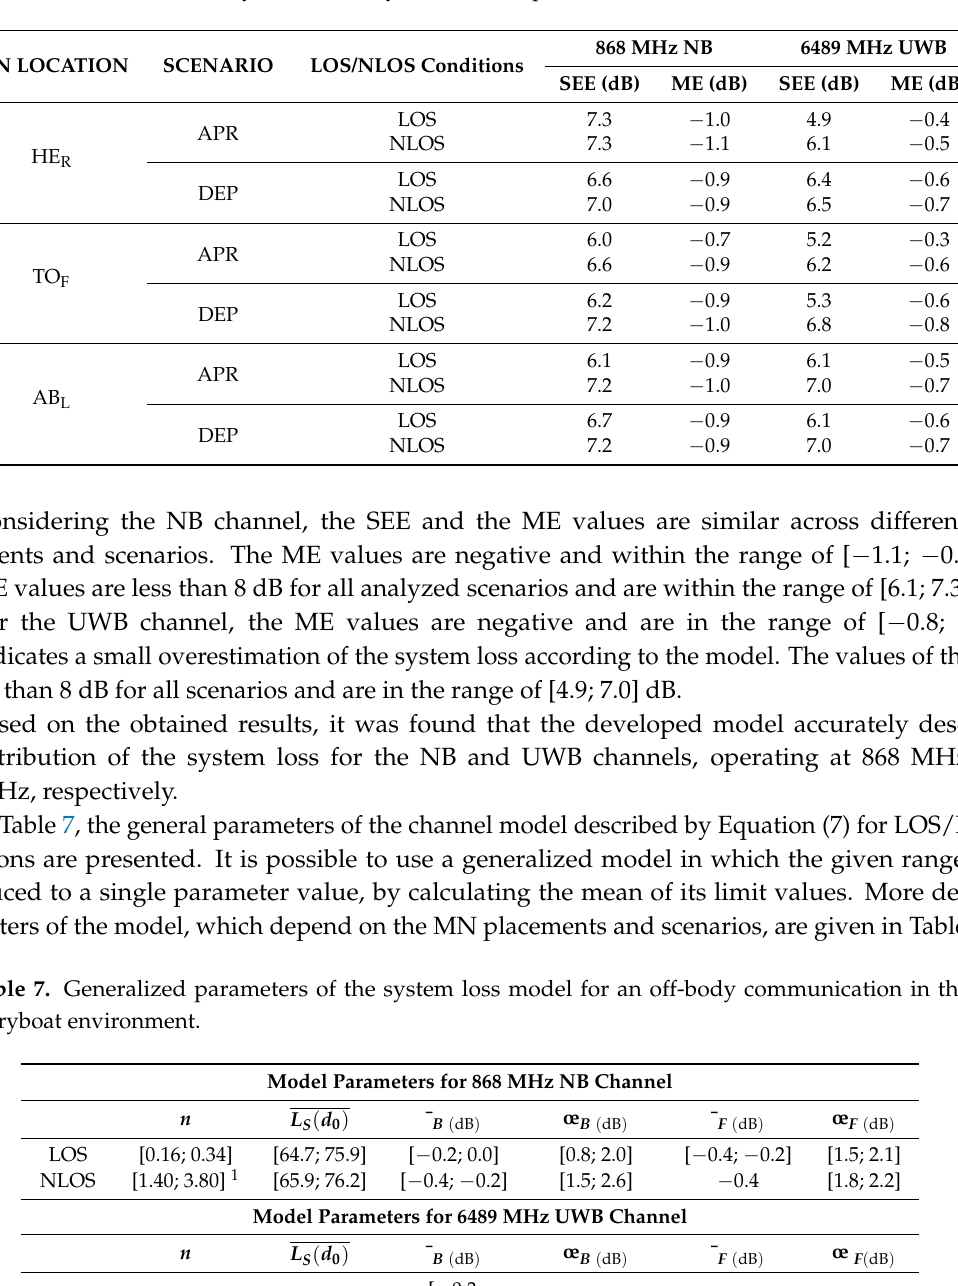
Table 6. A statistical analysis of accuracy of the developed model for all measurement scenarios.